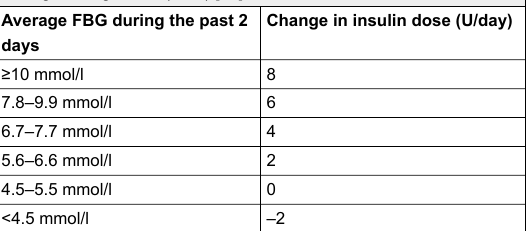
Change in insulin dose